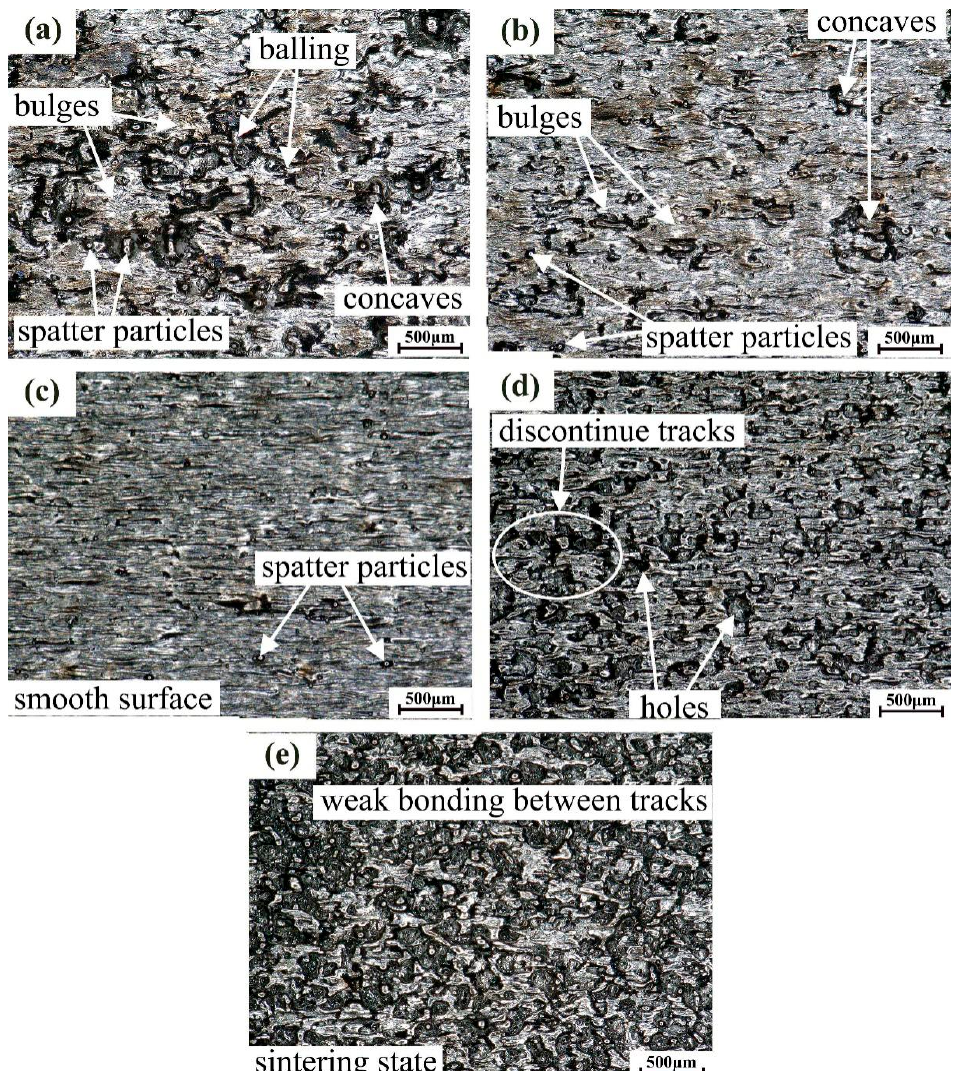
Figure 3. Surface morphologies of parts fabricated with parameters in different ranges: ( a ) serious over-melting zone; ( b ) high-energy density nodulizing zone; ( c ) smooth forming zone; ( d ) low-energy density nodulizing zone; ( e ) sintering zone.